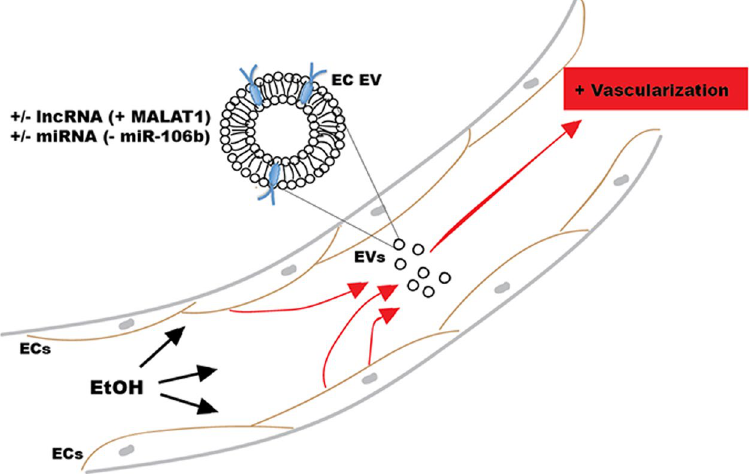
Figure 7. Schematic of potential mechanism of alcohol effects on endothelial cell (EC) EVs. EtOH = ethanol, miRNA = microRNA, lncRNA = long non-coding